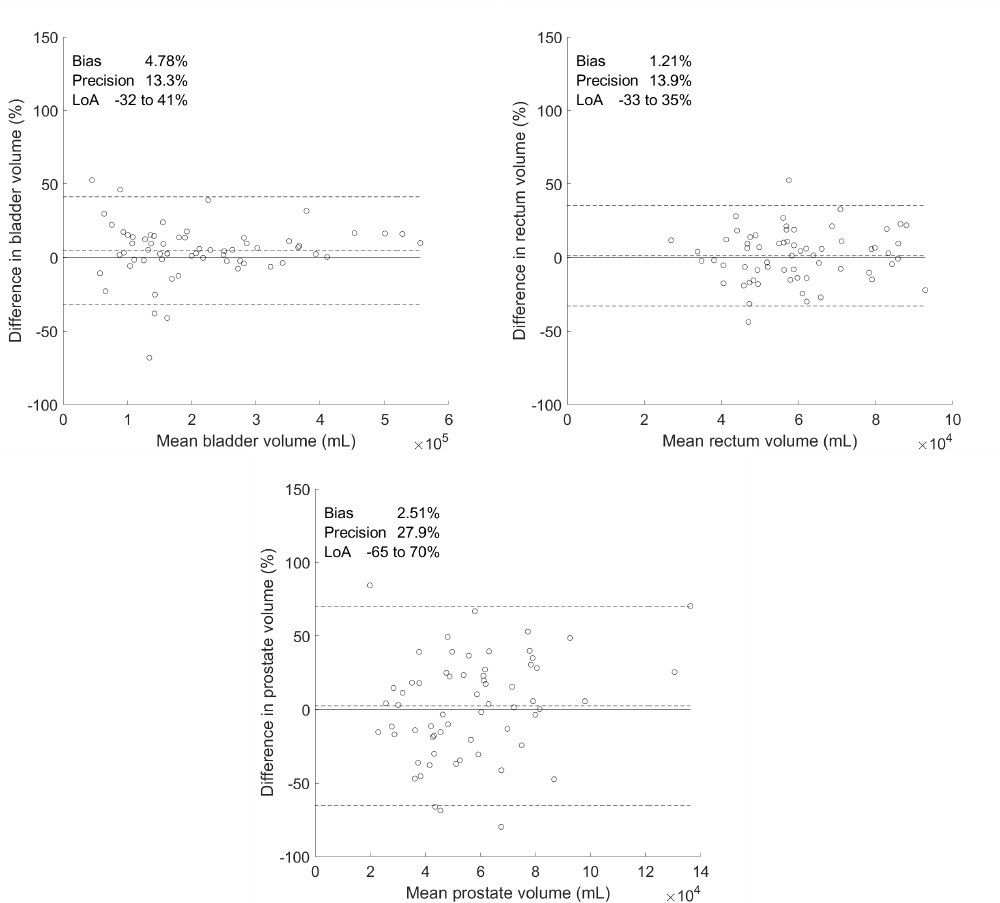
Figure 6. Bland–Altman plots for bladder, rectum, and prostate derived from the differences between the predicted and manual segmentations. The solid lines represent no difference; the dotted lines depict the mean difference (bias) and 95% limits of agreements